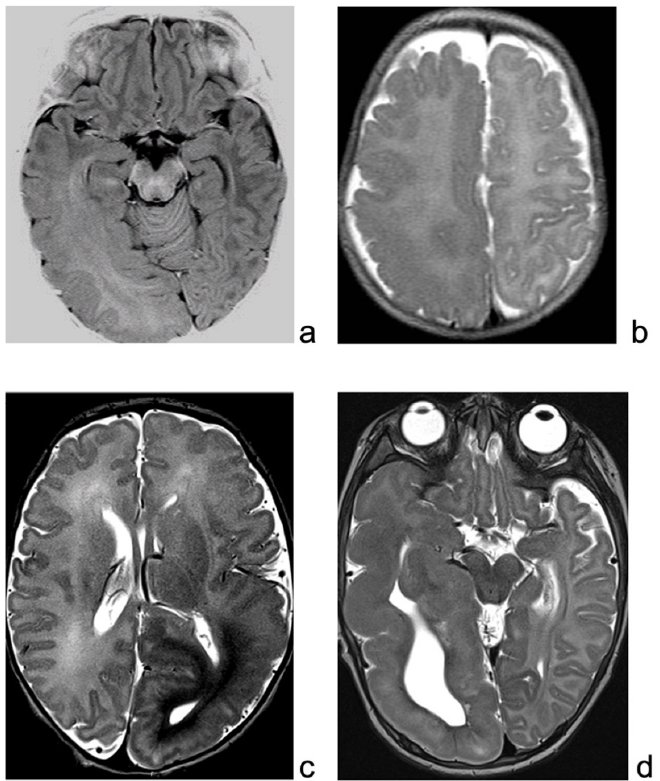
Figure 1. ( a ): MRI of patient 1, showing enlarged right hemisphere, with gray–white matter blurring mainly in the temporo-occipital regions. ( b ): T2-weighted sequence of patient 2 MRI, showing right enlargement of temporo-occipital regions, with blurring, extending also over the suprasylvian regions. ( c ): MRI of patient 3, showing enlarged and malformed cortex over the left hemisphere, mainly posteriorly. ( d ): MRI of patient 4, T2-weighted sequence, showing enlargement and malformation of left hemisphere, mainly temporal region.